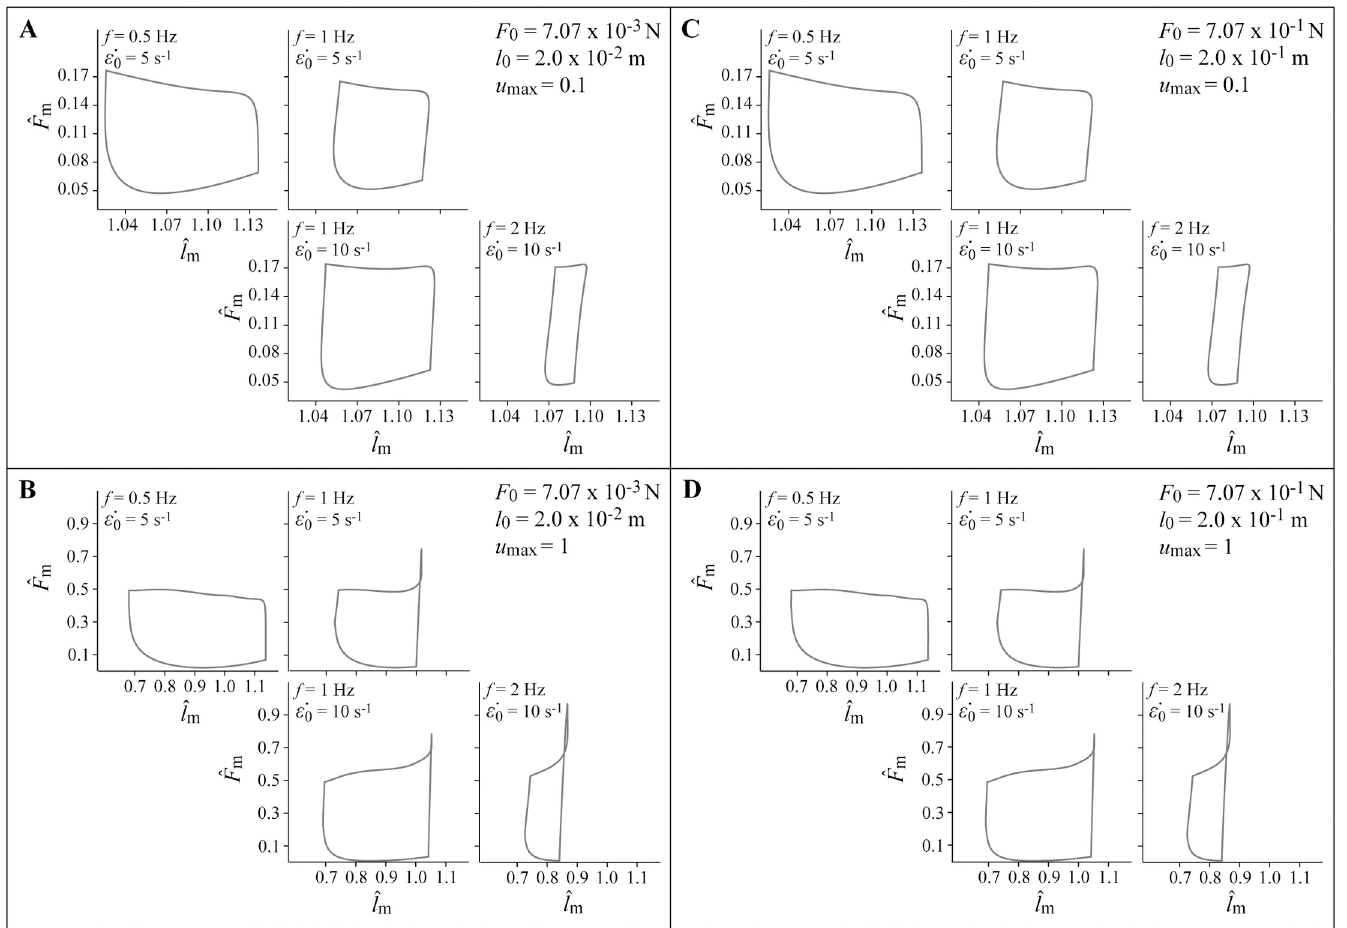
versus normalized muscle length ^ l for each simulation. Simulations m m